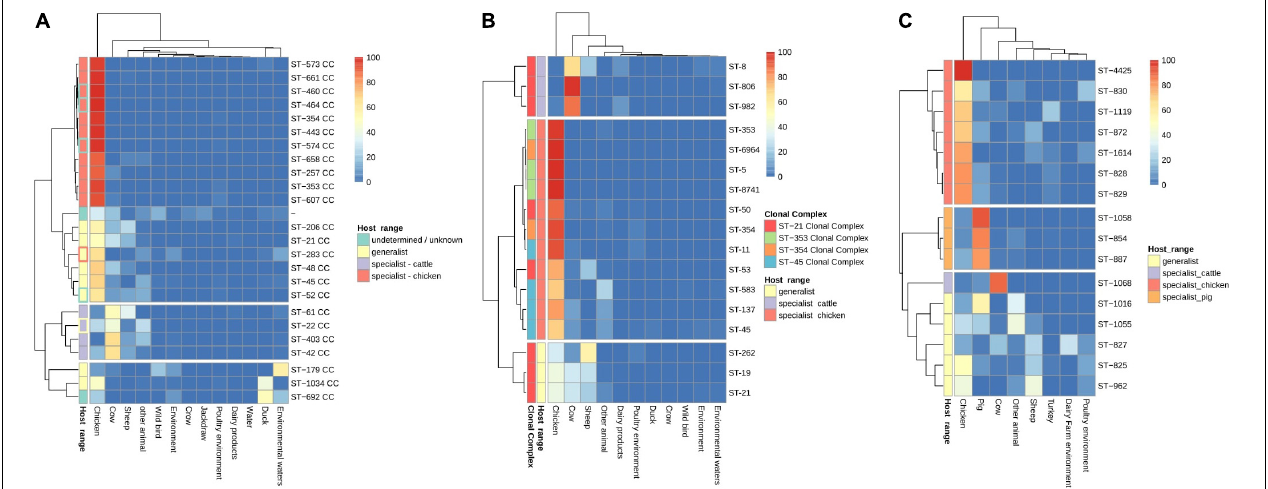
FIGURE 4 | CC and sequence type (ST) host specialization. Heatmap plot showing (A) percentage of C. jejuni genomes per CC, (B) C. jejuni genomes per ST within the four main CCs, and (C) C. coli genomes per ST within ST-828 CC belonging to each isolation source. Genomes belonging to the human isolation source were removed before the calculation of the relative abundances, and CCs/STs with 20 or less genomes were removed to avoid biases due to the low number of genomes. The Host range classification of C. jejuni CCs is according to previous publications (see Table 1 ), except for those with highlighted edges, where edge color indicates previous classification while fill color indicates the new assignment, according to the results obtained in the current